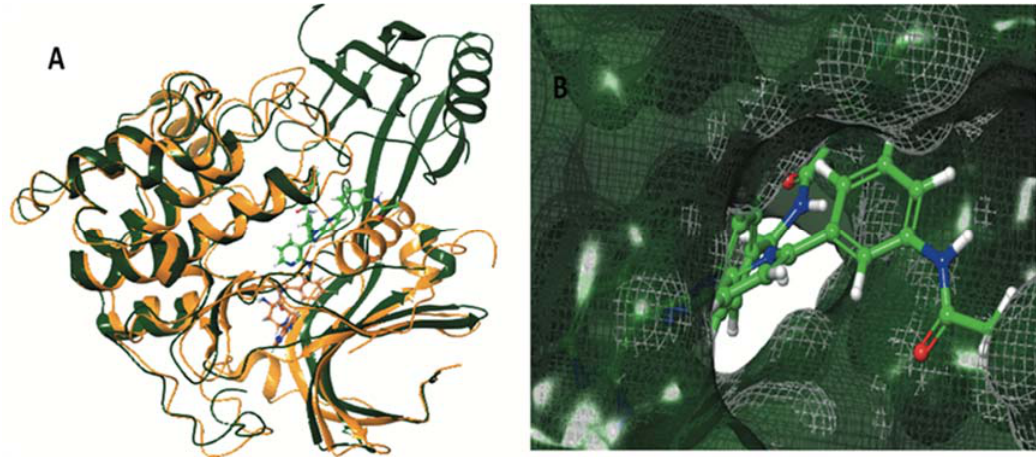
Figure 8. ( A ) Alignment of AKT1 with PDB ID 4EJN (ribbons with dark green) and AKT2 with PDB ID 2X39 (ribbons with yellow) with the co-crystallized inhibitor 0R4 (with green color) and X39 (with yellow color), respectively. ( B ) Surface of AKT1 and the binding site (grey) of the co-crystallized inhibitor 0R4.